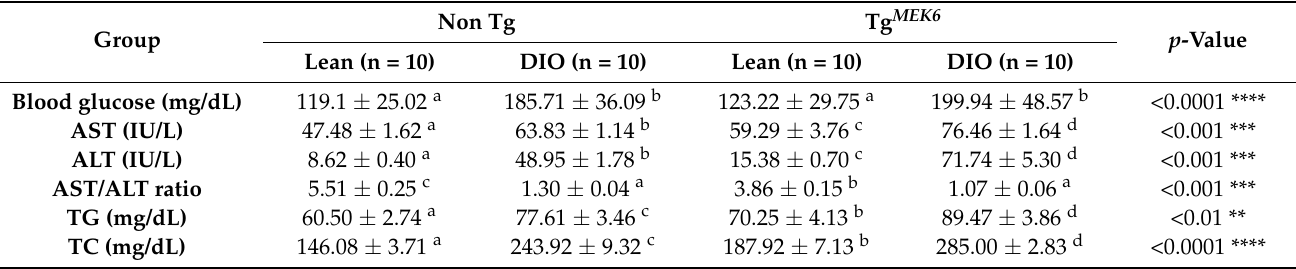
Table 2. Blood chemistry parameters in non-Tg and Tg MEK6